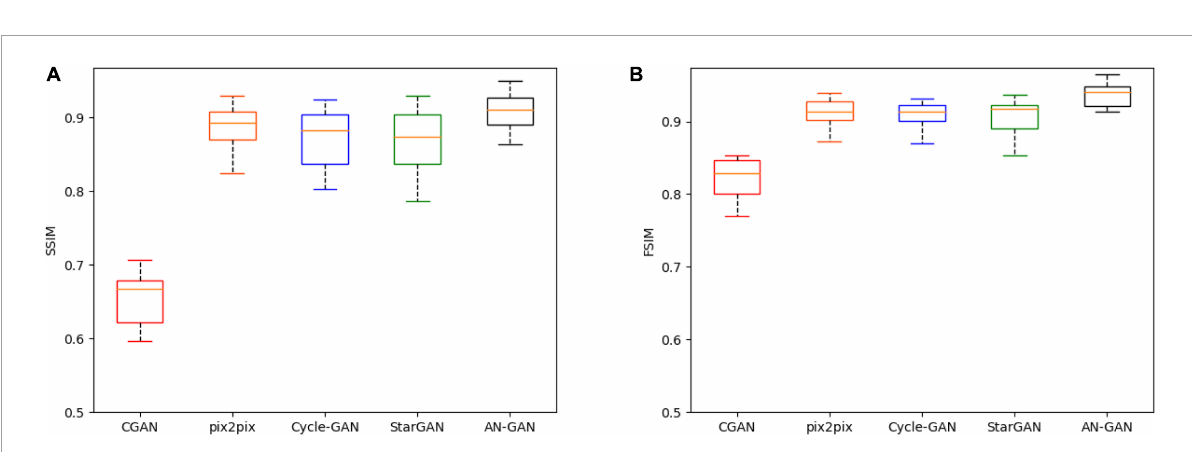
FIGURE7 Boxplots of SSIM (A) and FSIM (B) scores for synthetic images of three network models (CGAN, pix2pix, Cycle-GAN, StarGAN, and AN-GAN) on the test set.